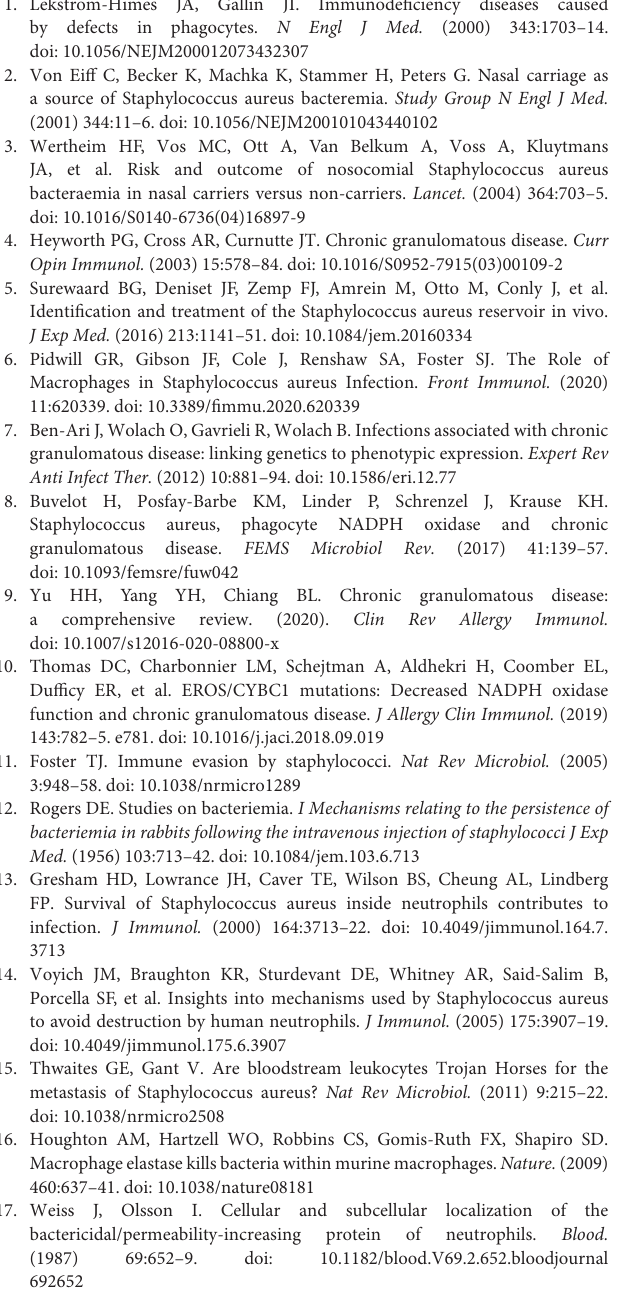
BMDMs. The grey filled plot represents non infected BMDMs. Fluorescence of infected BMDM samples was color-coded corresponding to specific time points p.i.: t0, red line; t6h p.i., dark blue line; and t24h p.i., light blue line. The corresponding fluorescence values are presented in plots. T0 reflects the time point after infection followed by immediate lysis of extracellular S. aureus by lysostaphin. (C) Representative histograms of BMDMs infected with an MOI15 of GFP-expressing S. aureus MW2. These plots correspond to results as shown in Figures 2A–D , respectively. Note different scale of Y-axis for the top